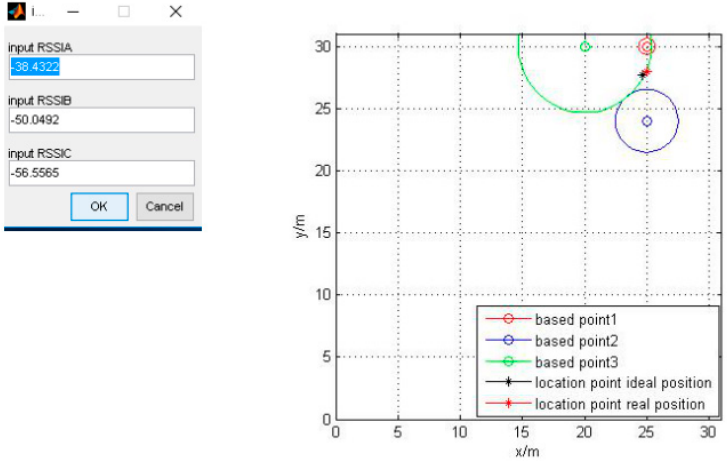
Figure 10. Simulation result when the RSSI values are − 45.1862, − 55.7421, and − 58.1185 (dBm) for the three points (a, b, and c).